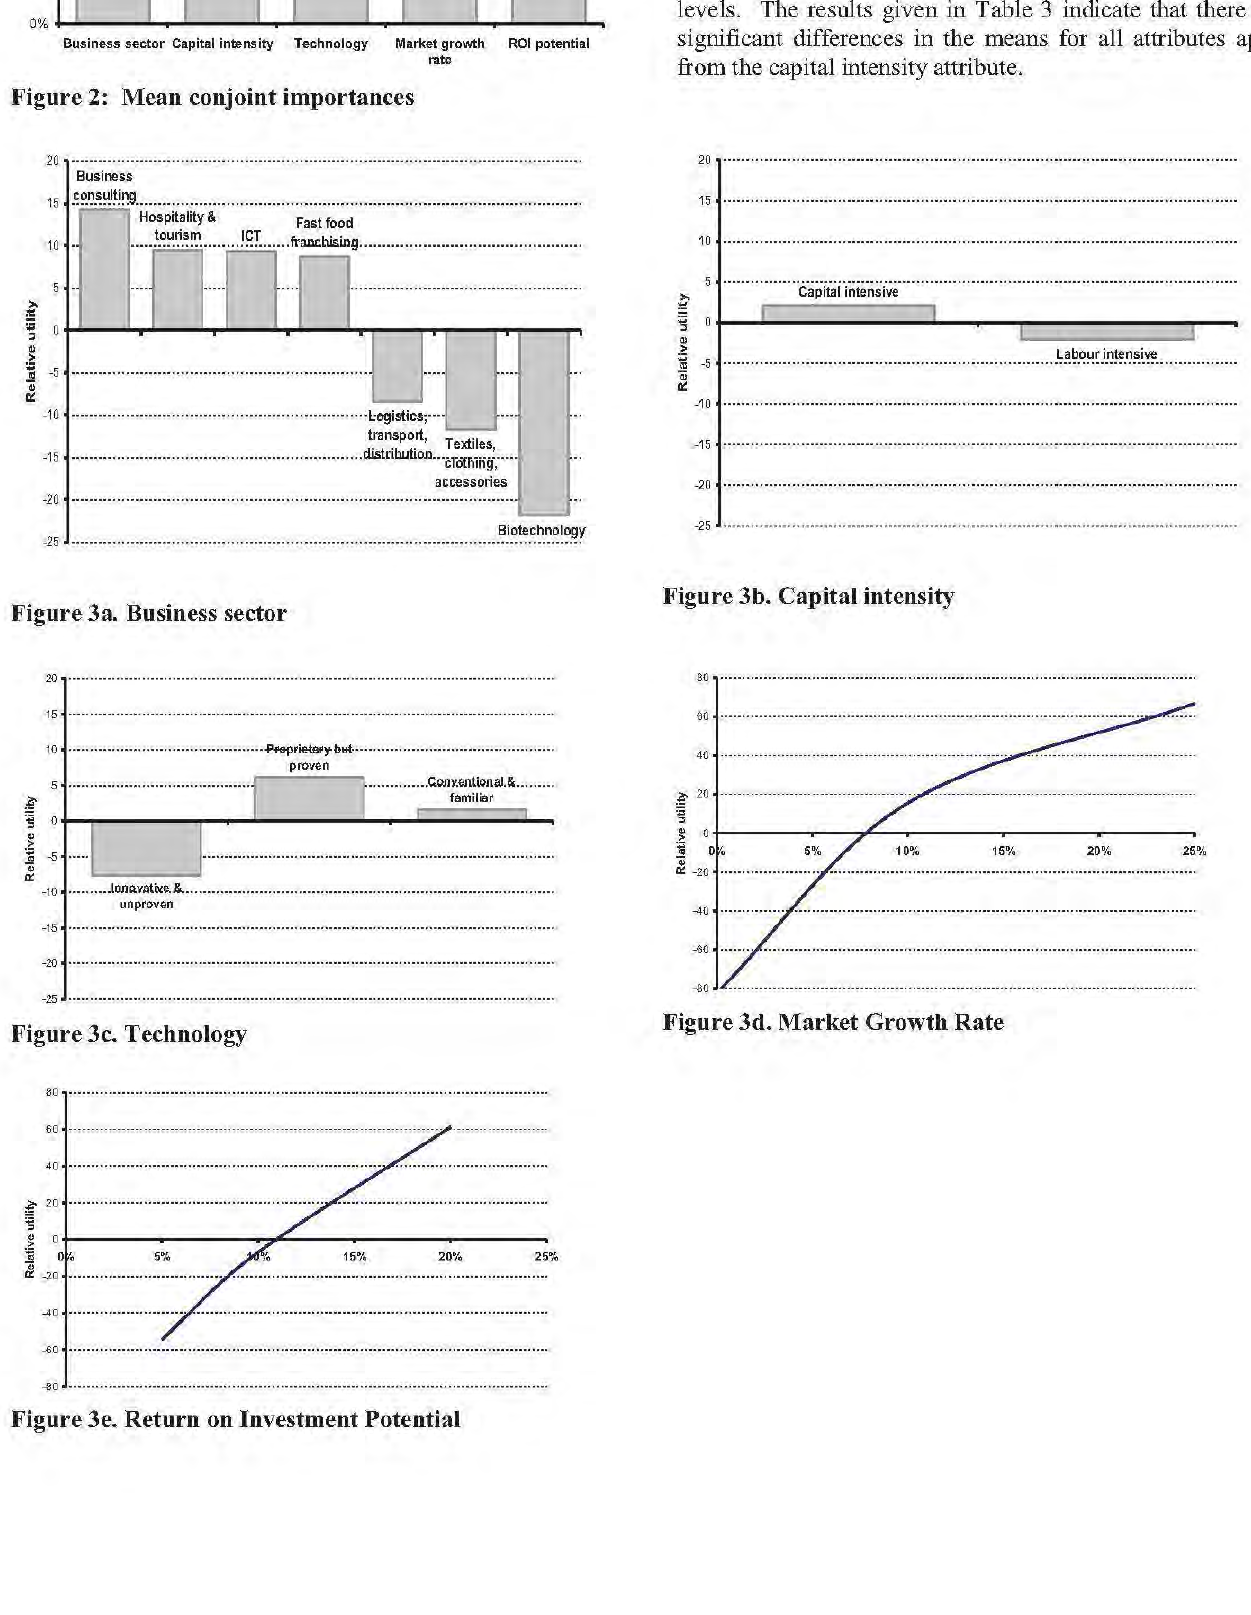
Figure 2: Mean conjoint importances